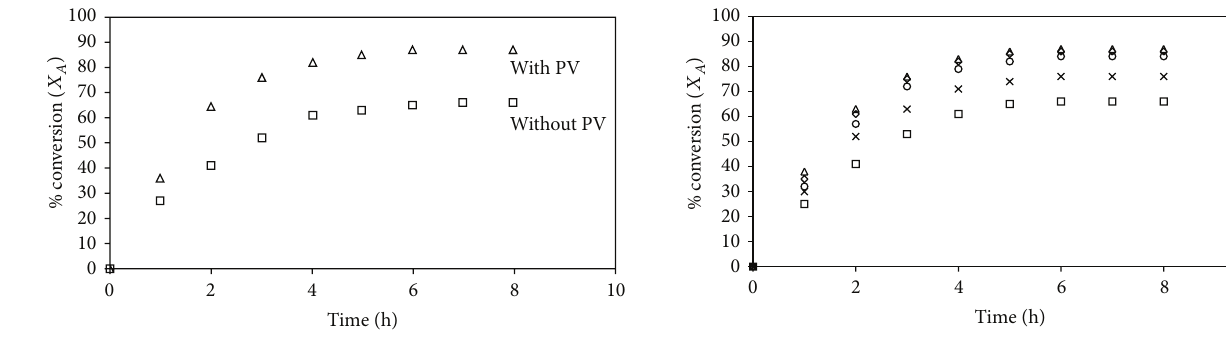
Figure 3: Comparison of experimental results for propionic acid conversion ( 𝑇 = 80 ∘ C; 𝐶 𝐶 = 0.358 kmol/m 3 ; 𝑅 = 1.4; 𝑆/𝑉 = 15.19 m 2 /m 3 ): with PV ( 󳵻 ) and without PV ( ◻ ).